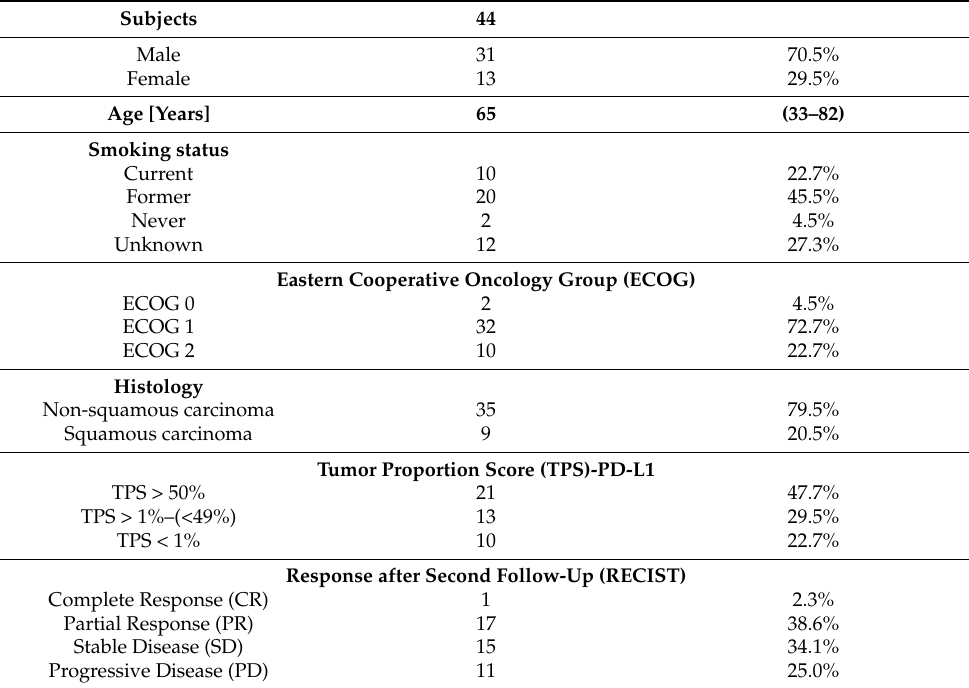
Table 1. Patients’ characteristics. Values are presented as median (interquartile range) or frequency